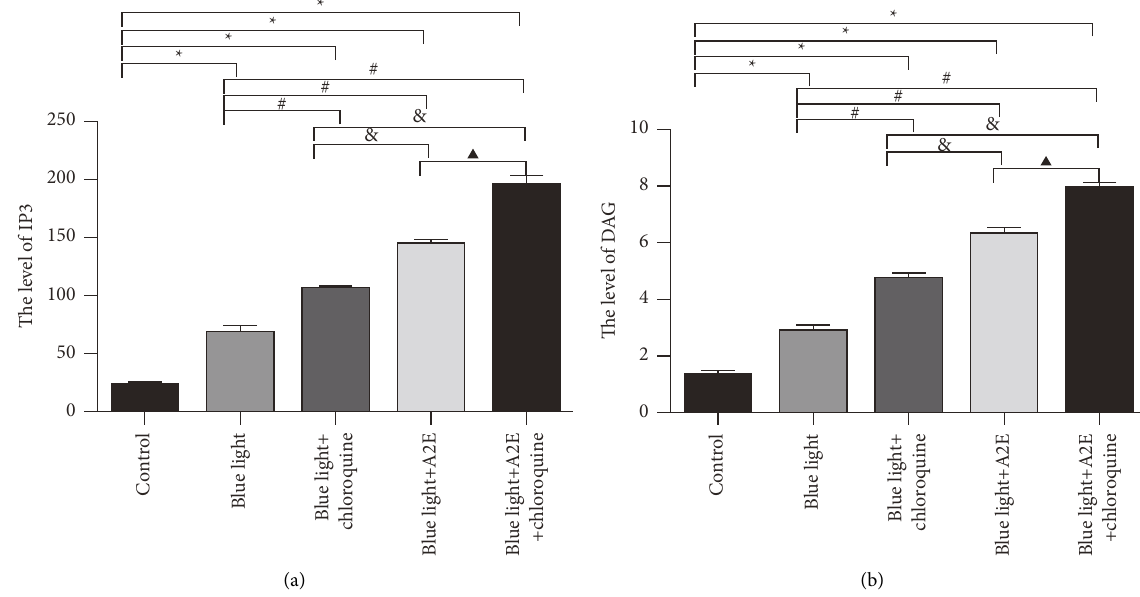
Figure 3: Intracellular IP3 and DAG levels in RPE cells. The intracellular levels of IP3 and DAG were measured by ELISA. The data are shown as the mean ± SD ( n � 3). An LSD test following one-way ANOVA was performed. ∗ P < 0 . 05 vs. control cells; # P < 0 . 05 vs. blue light- treated cells; & P < 0 . 05 vs. blue light+chloroquine-treated cells; ▲ P < 0 . 05 vs. blue light +A2E-treated cells.